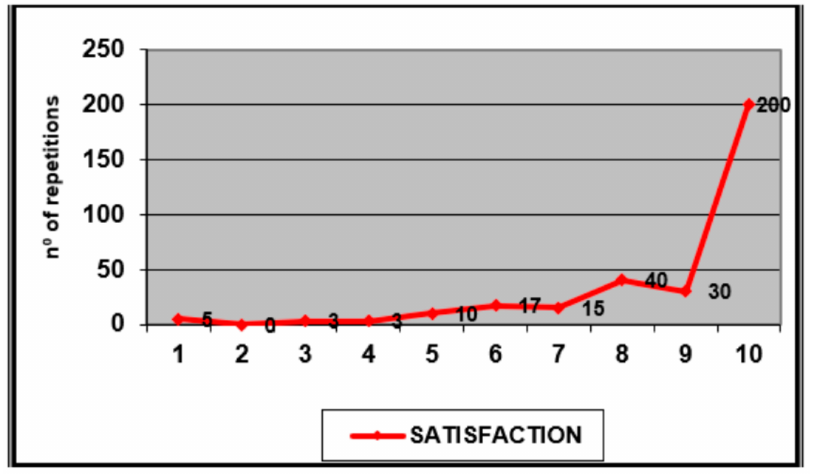
Figure 6. Satisfaction with women supervisors, 2019. Source: Compiled by the